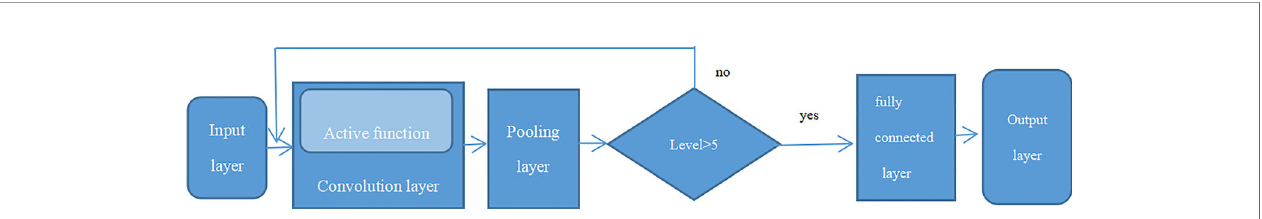
FIGURE 6 | Convolutional neural network structure, A complete convolutional neural network basically includes fi ve components: input layer, convolutional layer, pooling layer, fully connected layer and output